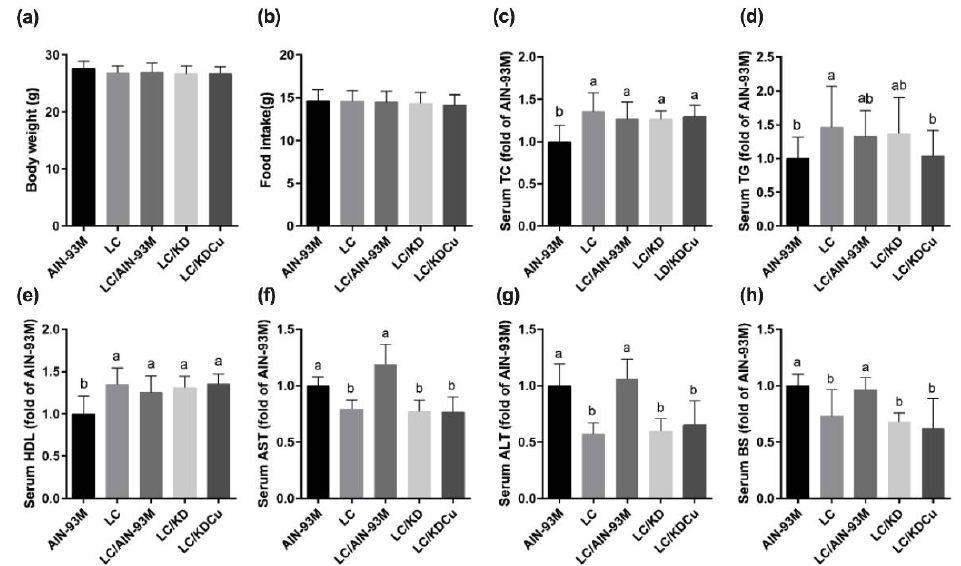
Figure 1. Effects of the low carbohydrate diet and curcumin on ( a ) body weight, ( b ) food intake, ( c ) serum total cholesterol (TC), ( d ) serum triglycerides (TG), ( e ) serum high density lipoprotein (HDL), ( f ) serum aspartate aminotransferase (AST), ( g ) serum alanine aminotransferase (ALT), ( h ) serum glucose in male mice. Data are expressed as means ± SD. (( a , b ) n = 11–12; ( c – h ) n = 7–12 per group). Bars ( a, b) with different letters indicate that values are significantly different. (One-way ANOVA, Duncan’s test, p < 0.05). AIN-93M: AIN-93M diet; LC: low carbohydrate diet; LC/AIN-93M: low carbohydrate diet changed to AIN-93M diet; LC/KD: low carbohydrate diet changed to ketogenic diet; LC/KDCu: low carbohydrate diet changed to ketogenic diet and curcumin.